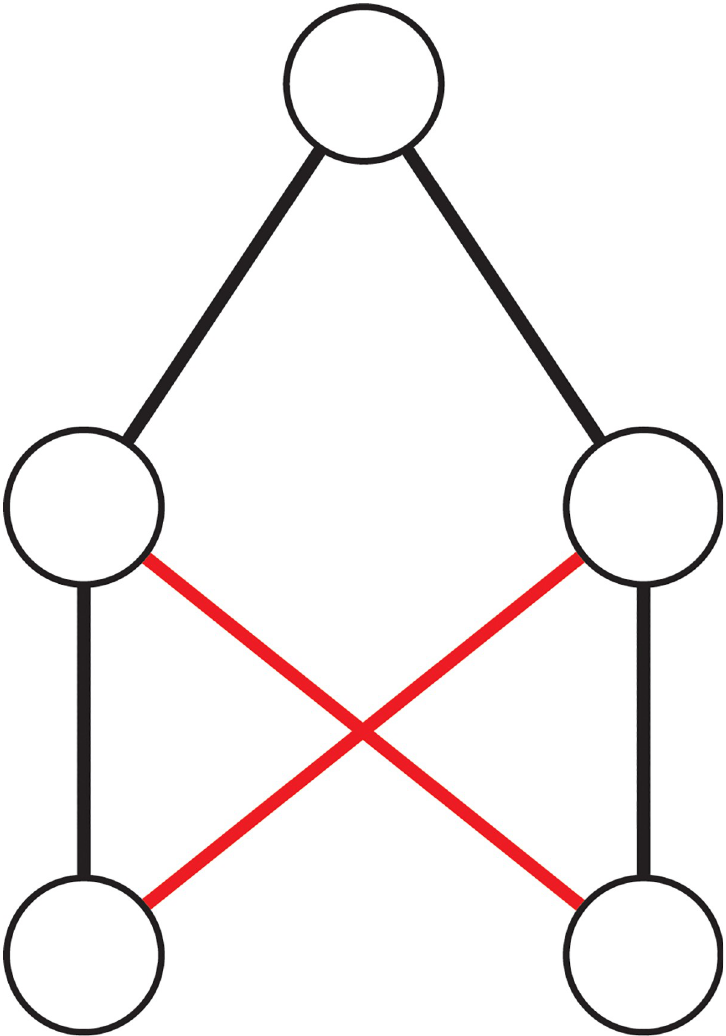
Fig 3. Incestuous relationship loop, in which two supervisors who are children of the same intellectual parent, examine each other’s students. Black lines denote supervisory relationships. Red lines denote examiner relationships.